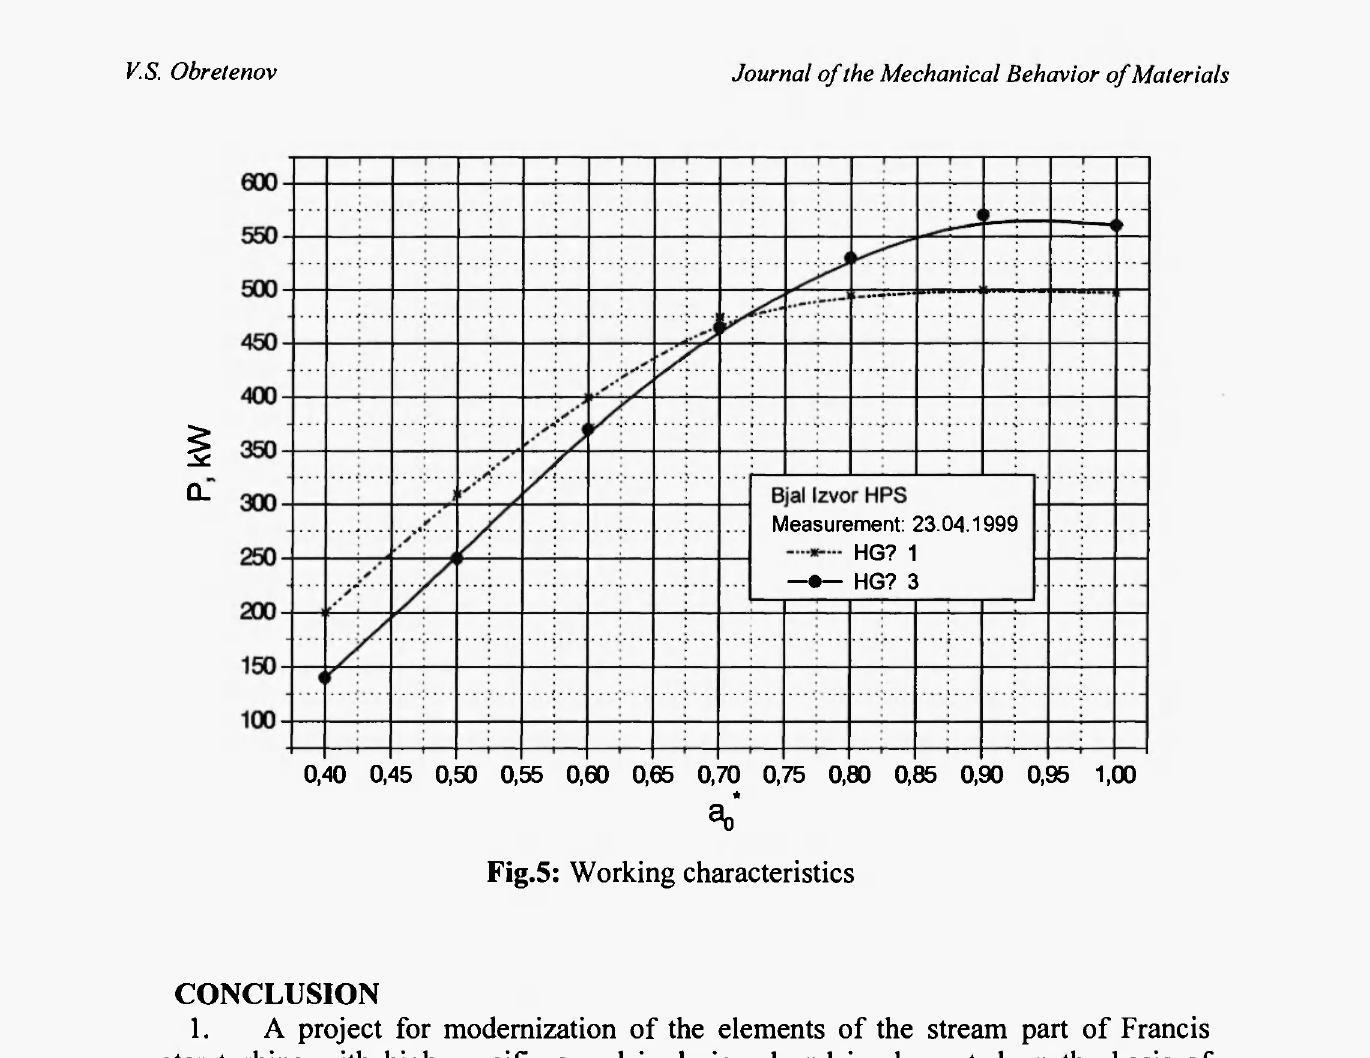
Fig.5: Working characteristics